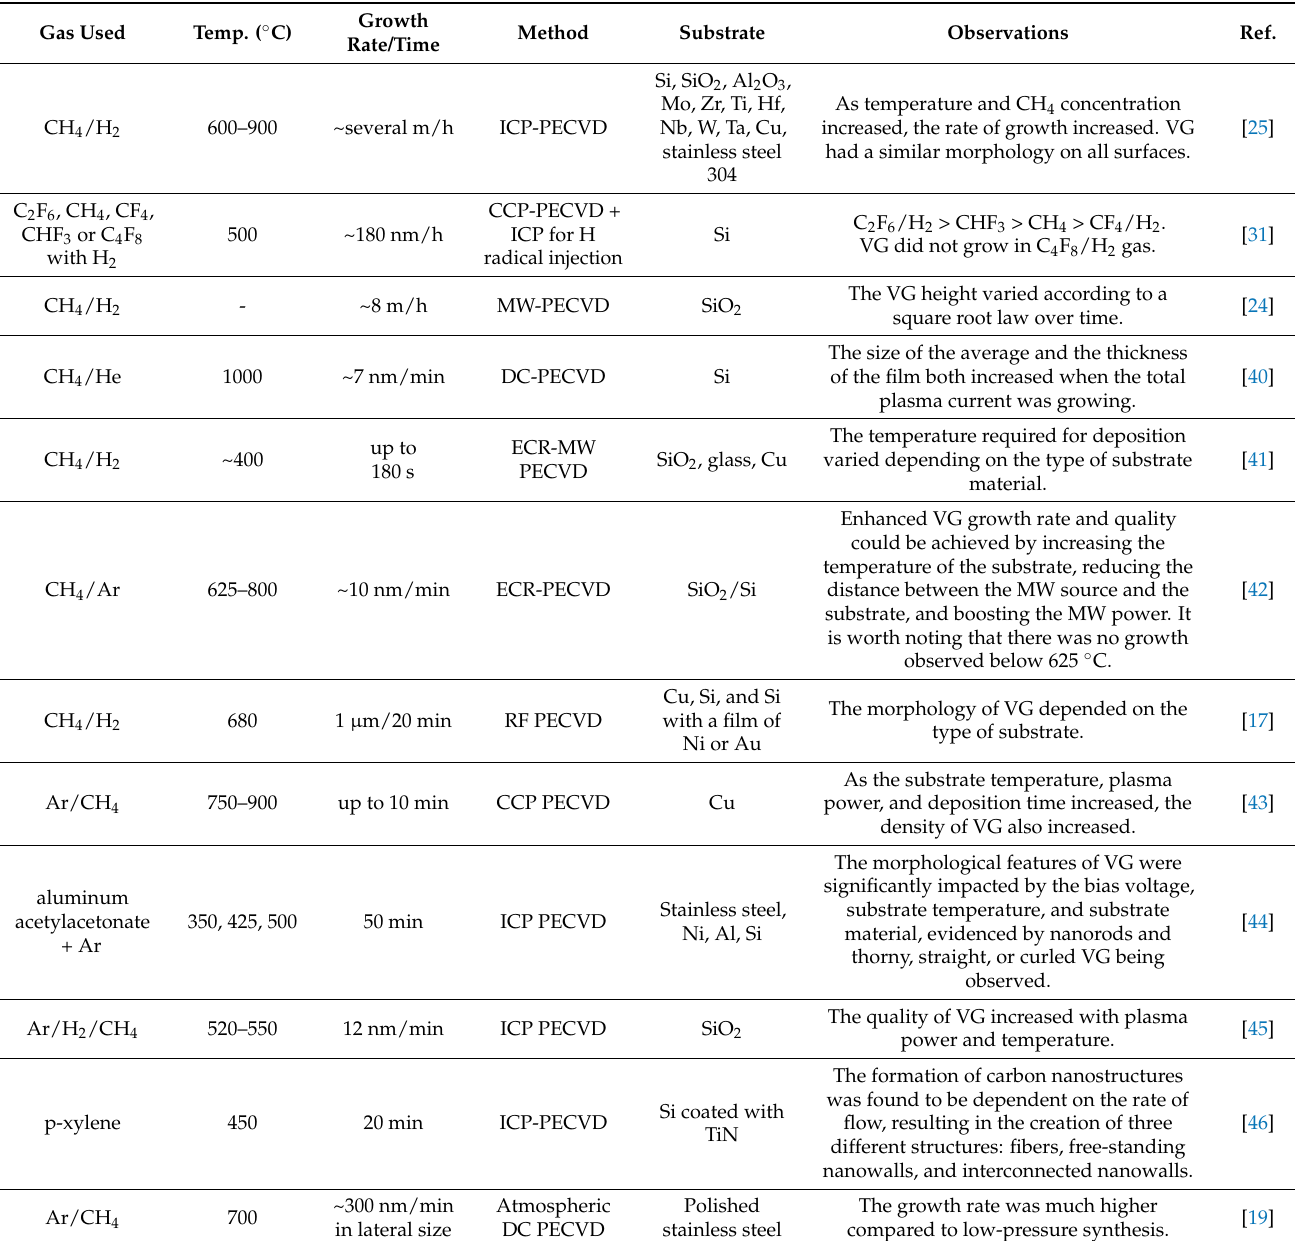
Table 1. VG growth methods and process